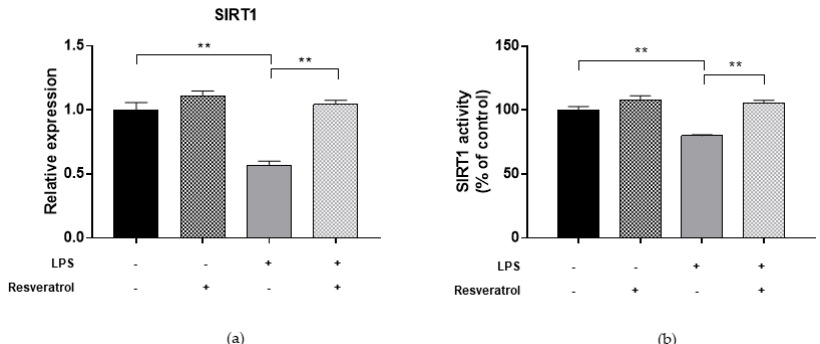
Figure 5. DNMT expression and activity in ARPE-19 cells under inflammatory condition. ( a ) Analysis of gene expression showed that treatment with 10 µg/mL LPS for 24 h downregulated DNMT1 expression level (FC = 0.50; p = 0.004), while ( b , c ) DNMT3A and DNMT3B expression seemed to be unaffected. ( d ) Analysis of total DNMT enzymatic activity using a colorimetric assay confirmed that total DNMT activity was reduced by 14.9% in LPS-treated cells compared to controls ( p = 0.007). Treatment with 10 µM resveratrol for 24 h restores DNMT1 expression (FC = 1.02, p = 0.002) and total DNMTs activity (104.8%, p = 0.009) in cells under inflammatory condition. The experiments were performed in triplicate and repeated three times. Bar graphs show mean ± SE. ** p < 0.01 based on the Student’s t -test.